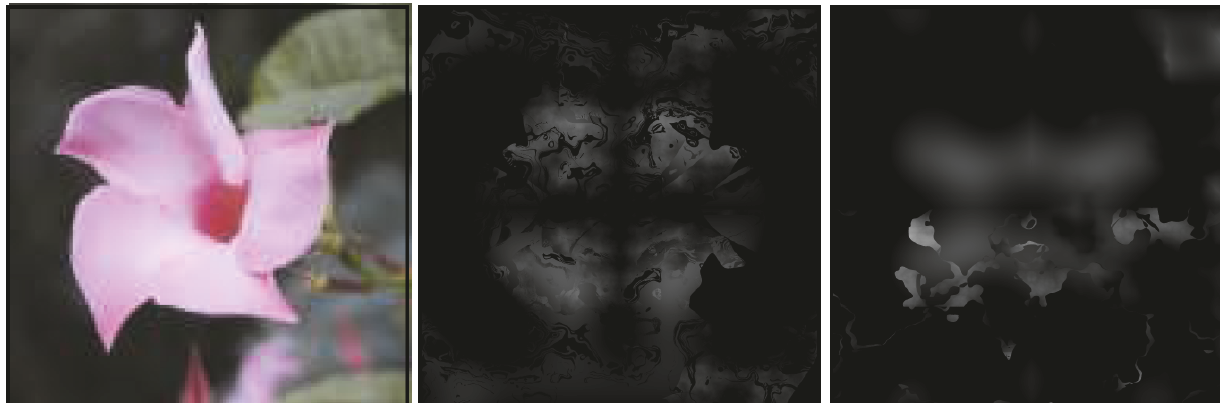
Figure 10: Produced image highlights; noisy language; flower. The leftmost image shows the target, followed by a pair of notable evolved candidates.